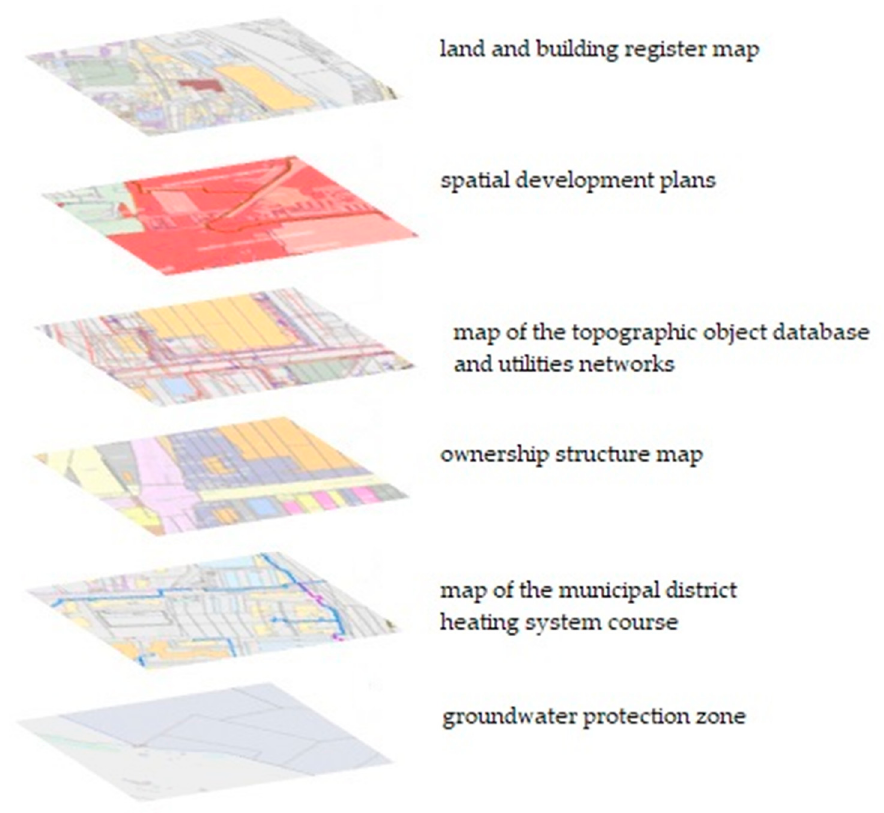
Figure 1. Map layers in the “Urban space and planning” infrastructure for spatial information ISI. Source: Own research based on www.msip.um.krakow (accessed on 25.09.2019).